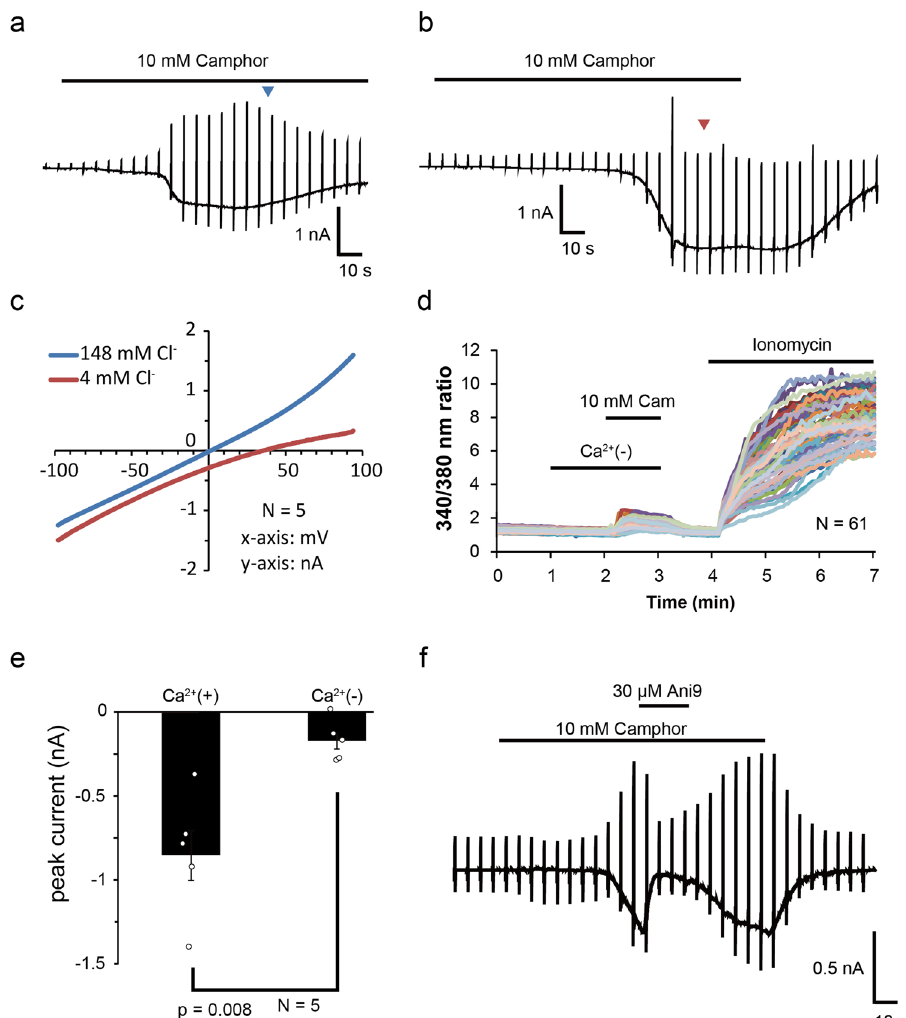
Fig. 3 TRPV3 and ANO1 interaction in NHEKs. a , b Representative traces of camphor-induced currents in NHEKs using an NMDG-Cl bath solution containing 148 mM chloride ( a ) or an NMDG-aspartate bath solution containing 4 mM chloride ( b ). The pipette solution contained 140 mM NMDG-Cl and 100 nM free calcium. The holding potential was − 60 mV and ramp-pulses were applied from − 100 to + 100 mV for 300 ms duration every 5 s. c Comparison of current – voltage relationships of the currents at arrowheads in ( a , b ). d Calcium imaging of NHEKs upon camphor application with and without (Ca 2 + ( − )) extracellular calcium. e Comparison of camphor-induced peak currents at − 60 mV in an NMDG-Cl bath solution with 2 mM (Ca 2 + ( + )) or without (Ca 2 + ( − )) extracellular calcium (means ± SEM, N = 5). Statistical signi fi cance was determined with a Mann – Whitney test. f Camphor- induced current with an ANO1 inhibitor, Ani9, using an NMDG-Cl bath solution containing 148 mM